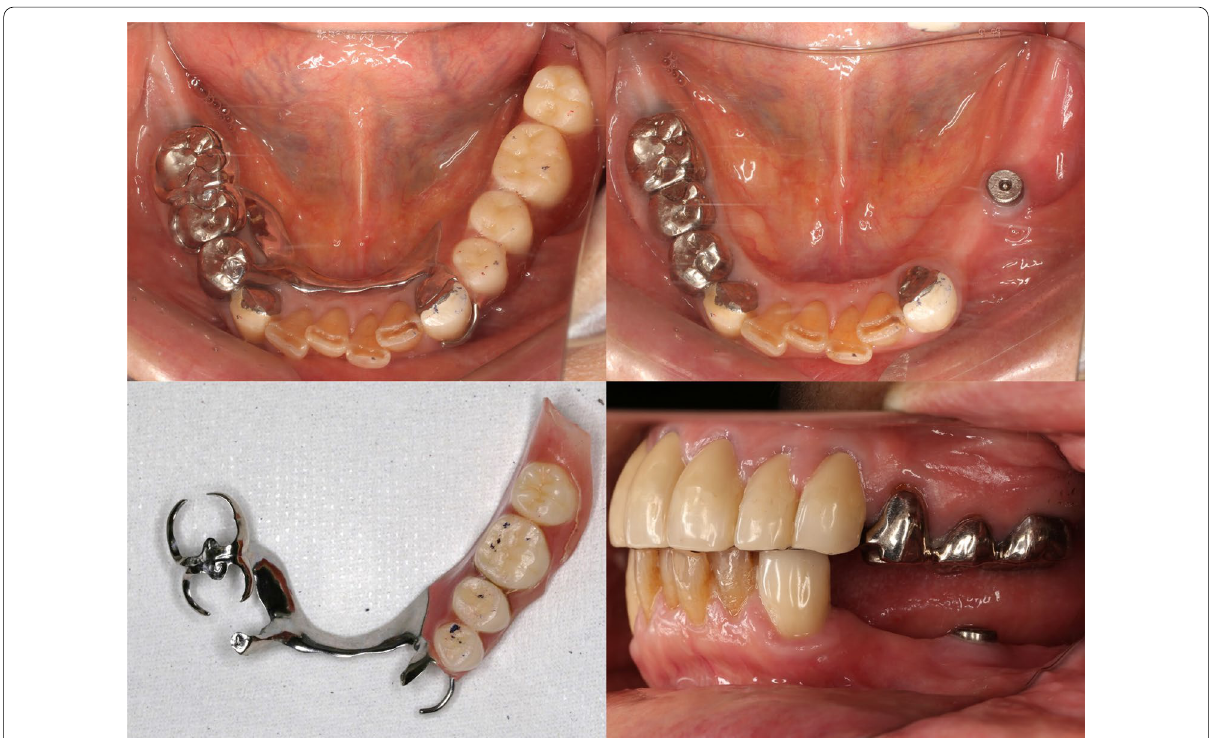
Fig. 2 Intraoral views of Case 1 with implant-supported removable partial denture in